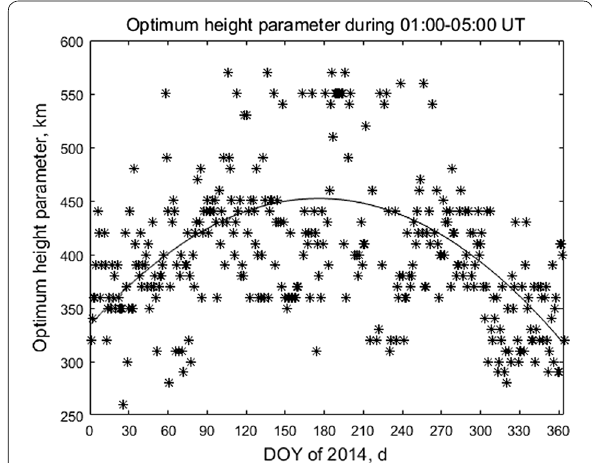
Fig. 9 Optimum shell height parameter during 01:00 UT to 05:00 UT in